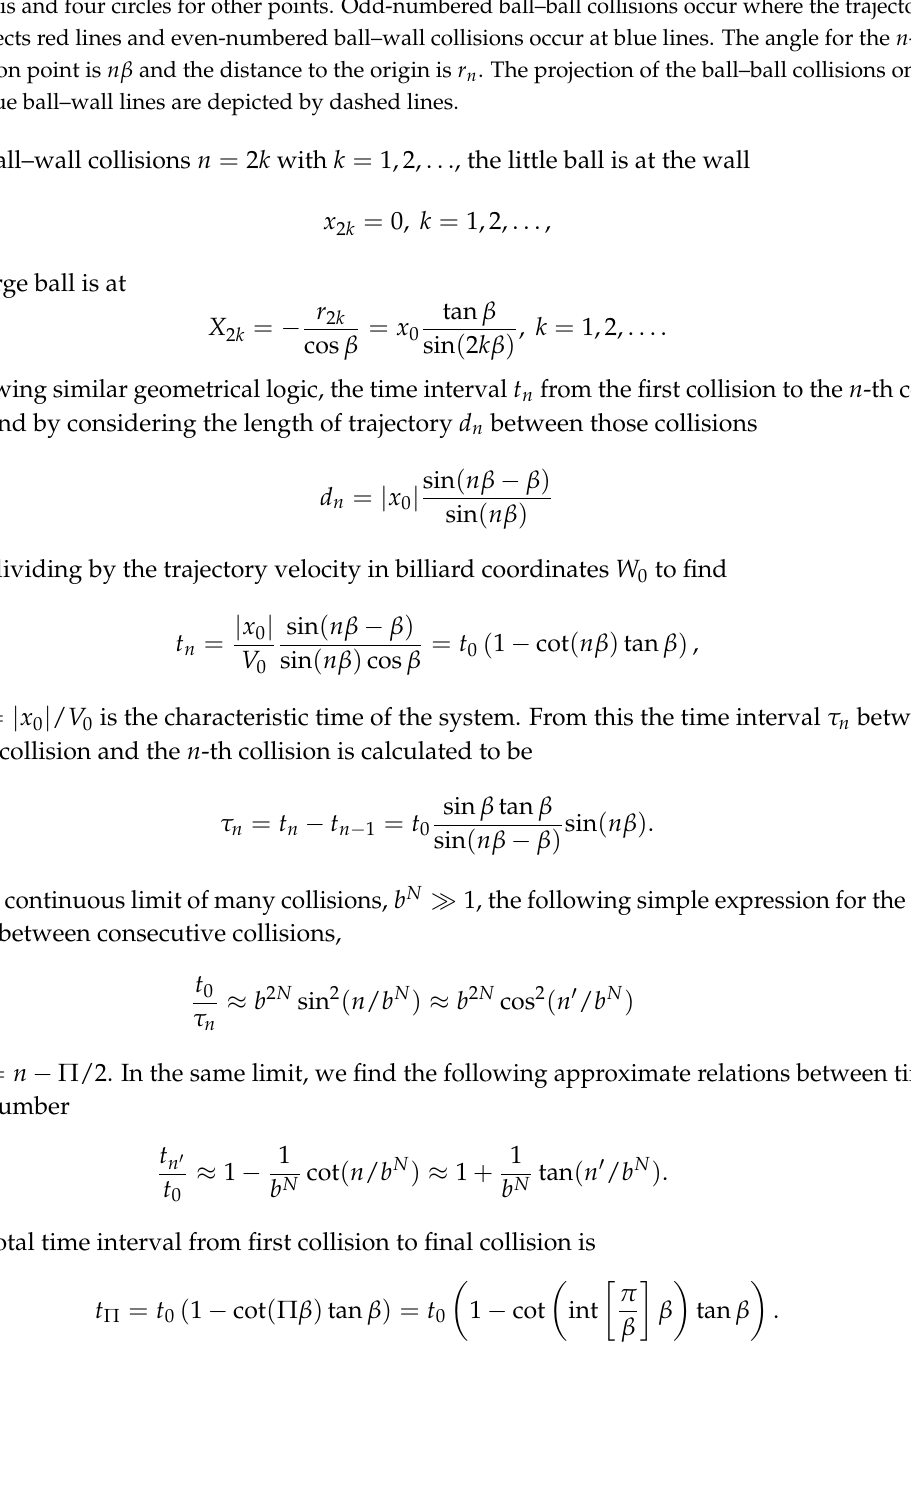
V 2 and speed W 0 = V 0 cos β . 0 0